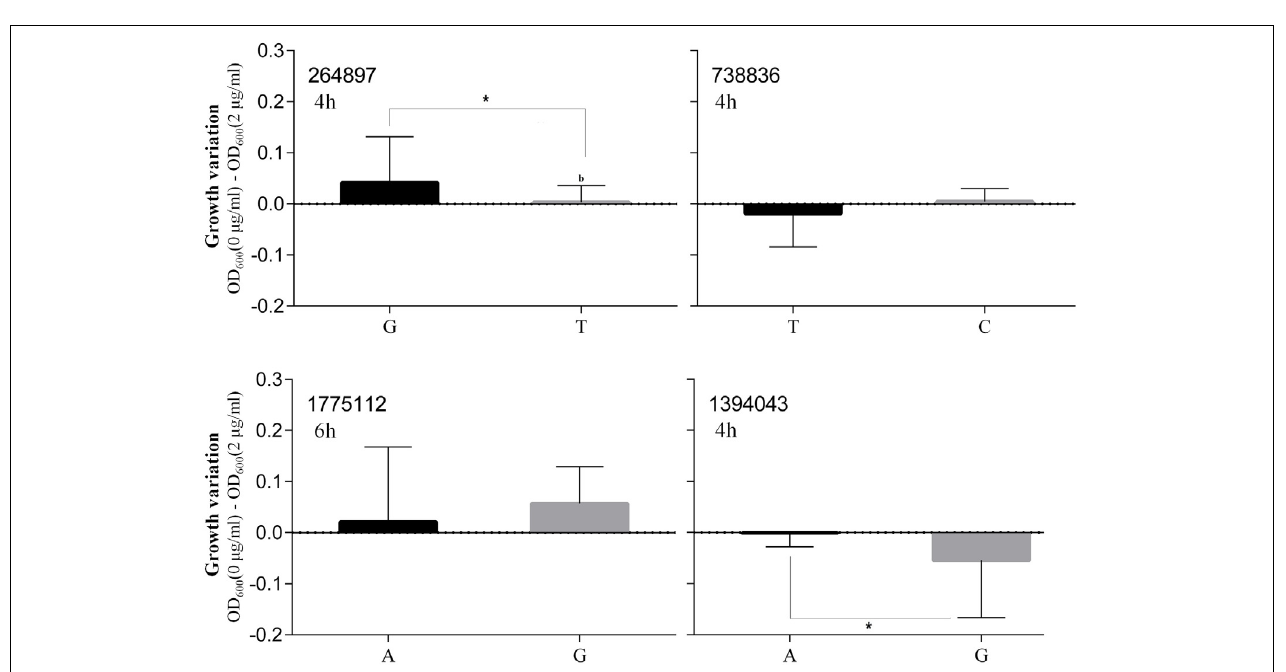
FIGURE 5 | Differences of the growth of two genotypes The x -axis represented two genotypes and the y -axis showed the growth variation between the two